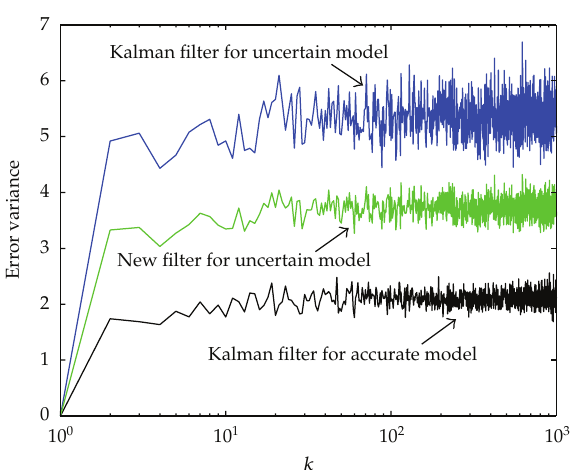
Figure 1: Comparison of the estimate variance x 1 k with di ff erent methods.